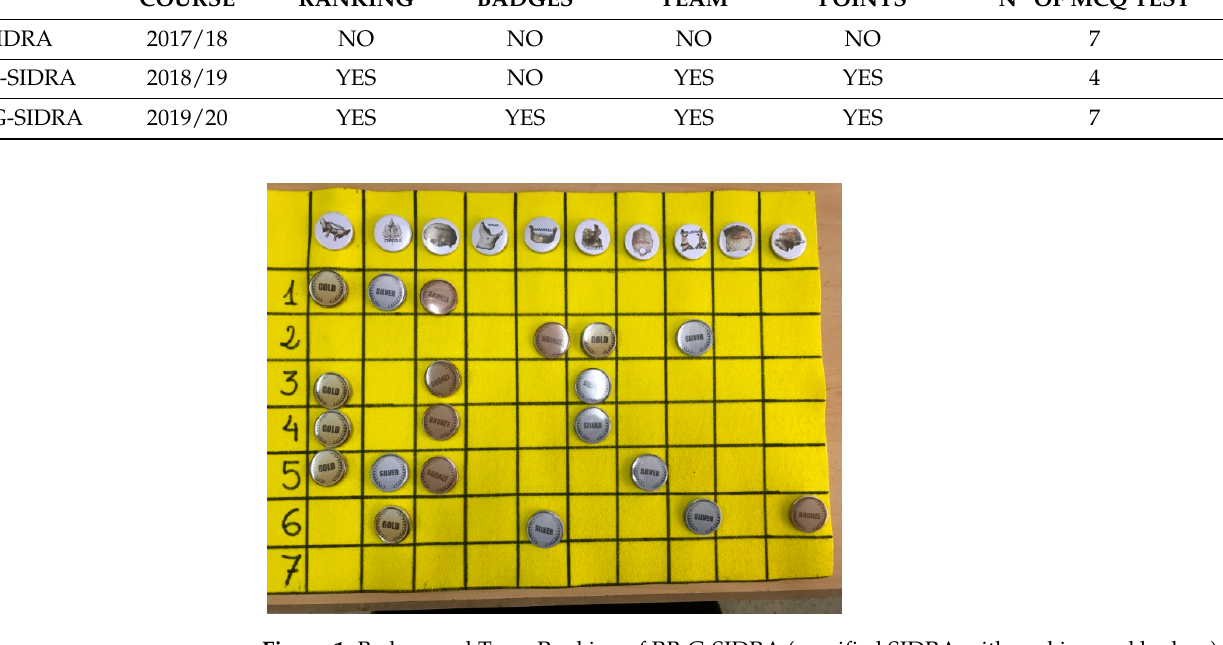
Table 1. Gamification Elements in SIDRA Systems (Immediate Audience Response System in Spanish). R-G-SIDRA (gamified SIDRA with ranking); RB-G-SIDRA (gamified SIDRA with ranking and badges).